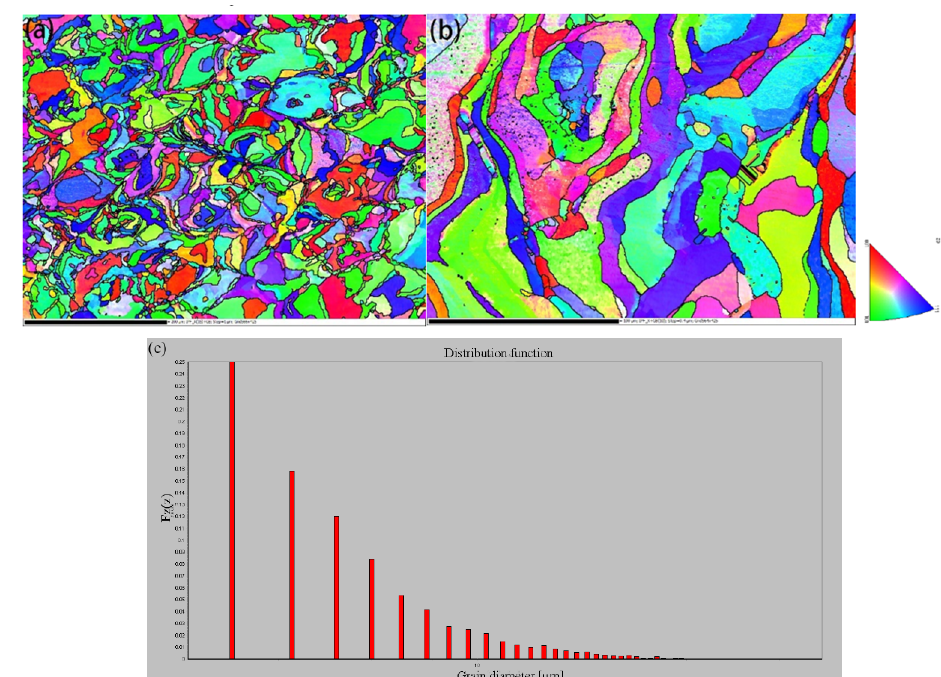
Figure 13. EBSD images of: ( a ) top view, ( b ) side view of SLM fabricated sample, ( c ) grain size distribution data statistics.